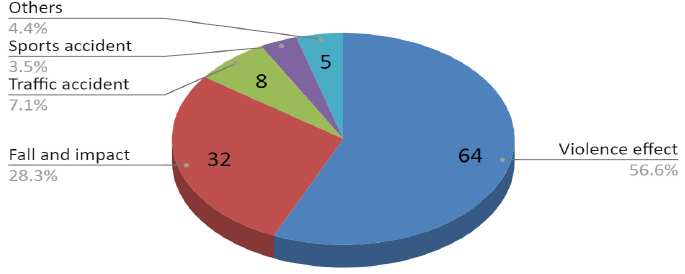
Figure 2. The causes of injuries for the entire study group.